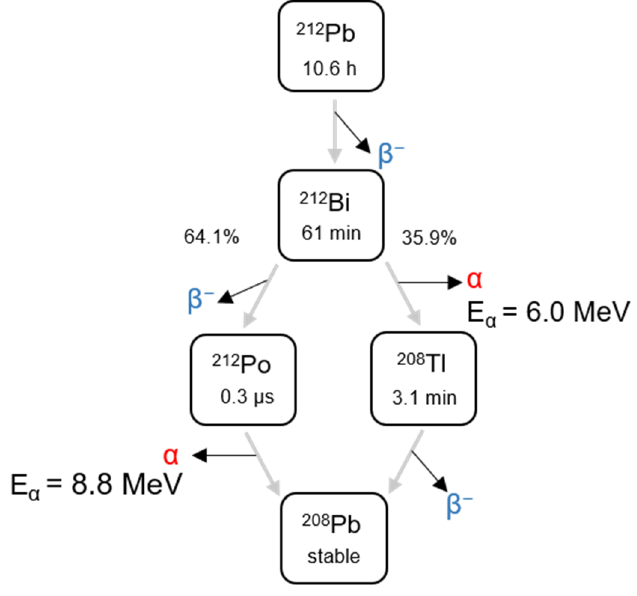
Figure 1. Decay scheme of 212 Pb with associated alpha particle energy from its daughters.